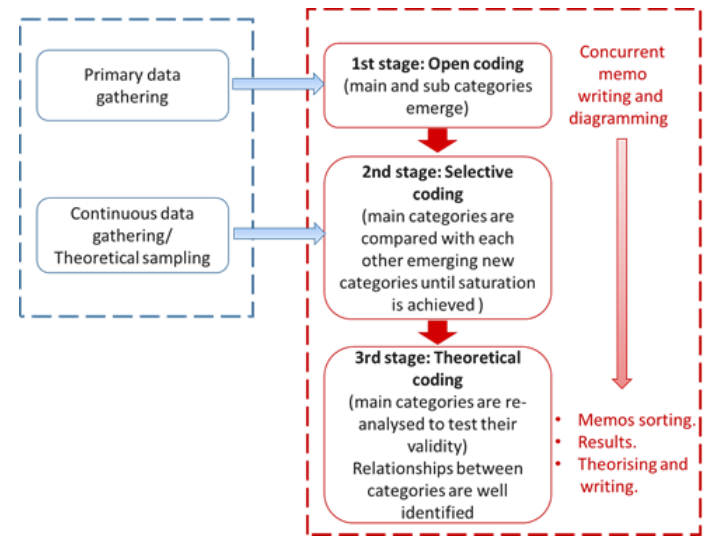
Figure 5. Constructivist grounded theory “substantive coding” coding stages used in this research. Adapted from: (Allen and Davey 2018).